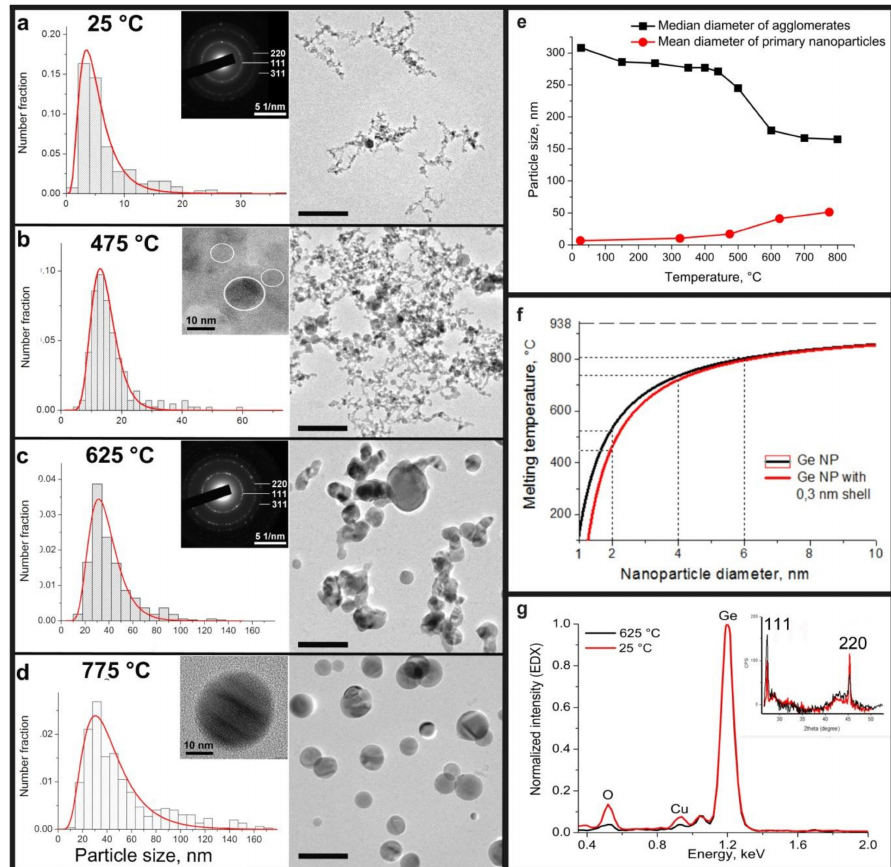
Figure 2. Evolution in morphology and particle size of germanium nanoparticles with increasing temperature: transmission electron microscopy (TEM) images and corresponding particle size distributions for samples, sintering at ( a ) 25, ( b ) 475, ( c ) 625 and ( d ) 775 ◦ C. The scale bar is 100 nm. Typical HRTEM images: insert ( b ) Ge crystals in a GeOx amorphous matrix, sintered at 25–475 ◦ C; insert ( d ): pure Ge crystal nanoparticles, obtained at high temperature synthesis (above 625 ◦ C); inserts ( a ), ( c ): a typical SAED pattern of prepared germanium nanoparticles with temperature sintering from 25 to 775 ◦ C; ( f ): the dependence of the melting temperature on the diameter of the germanium nanoparticles; ( g ): typical normalized EDX spectra of nanoparticles sintered at low (25–475 ◦ C) and high (above 625 ◦ C) temperatures and corresponding XRD spectra obtained from a Ge NP on cellulose filter